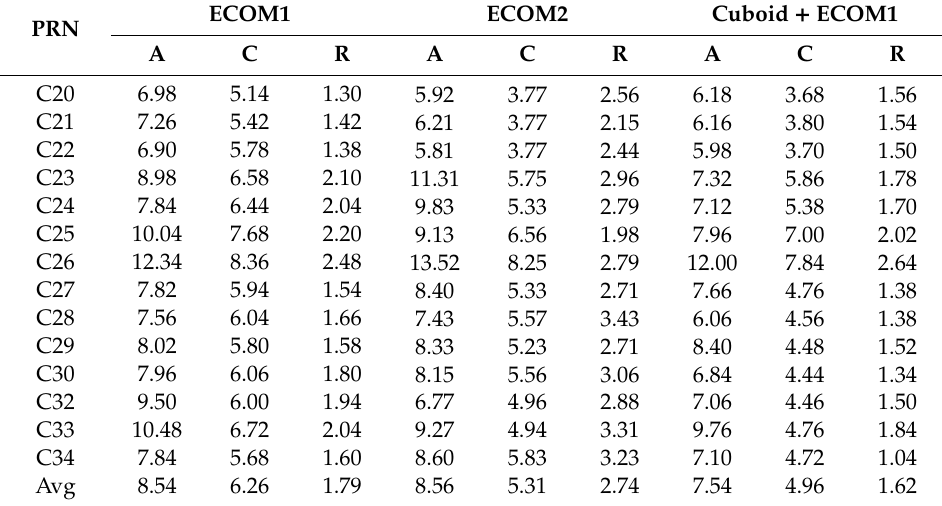
Table 6. The precision of the root mean square (RMS) of the 24 h orbit overlapping. The unit is cm. ECOM1 ECOM2 Cuboid + ECOM1 PRN A C R